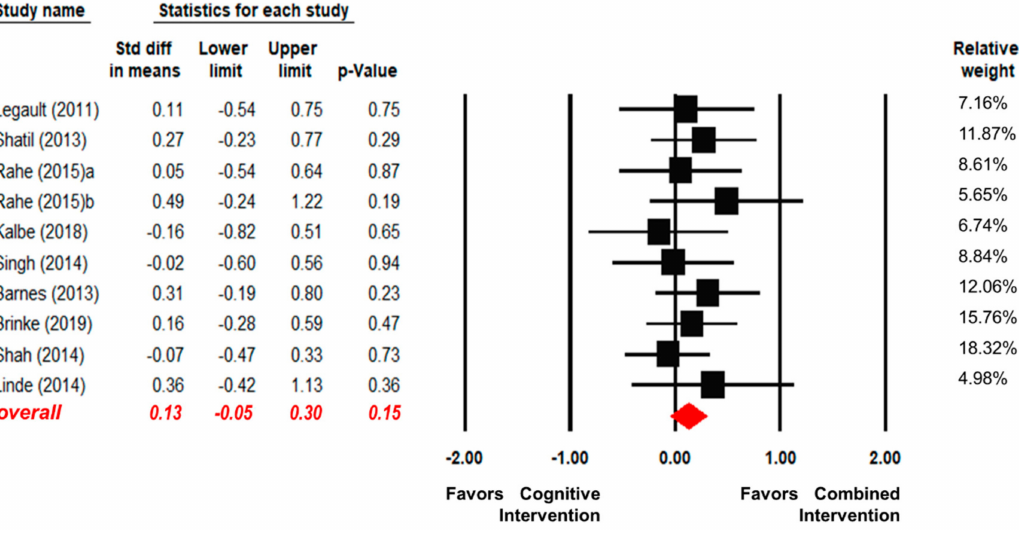
Figure 3. Forest plot for the e ff ect sizes of the combined interventions compared to the cognitive intervention alone.